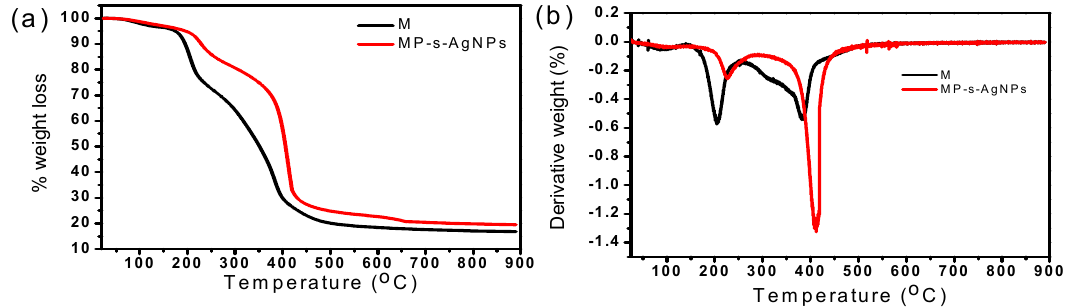
Figure 5. ( a ) TGA and ( b ) DTG curves of commercial milk (M) and MP-s-AgNPs.